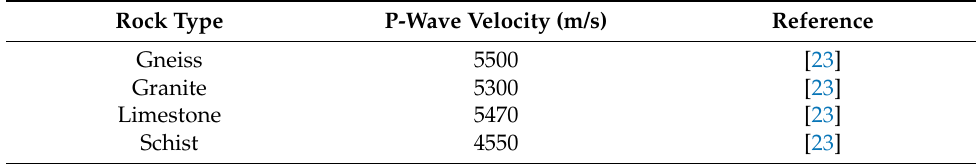
Table 2. Input values for types of